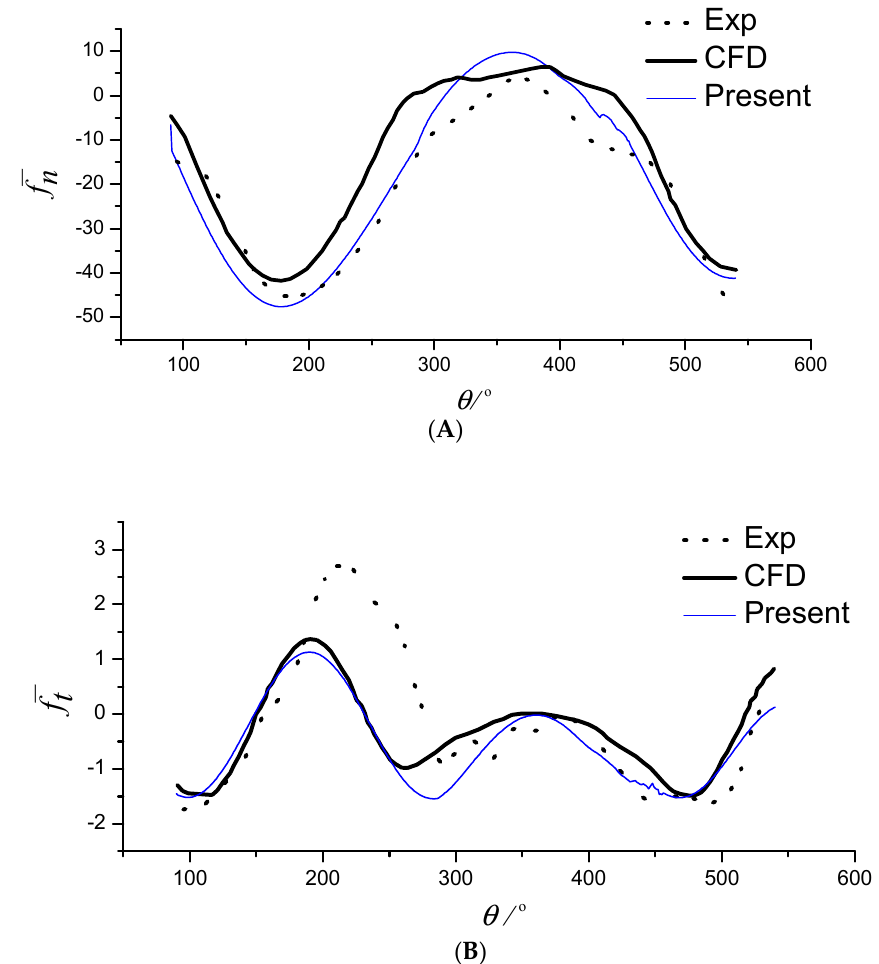
Figure 8. ( A ) Normal force coefficient ( λ = 7.5, Z = 2); ( B ) tangential force coefficient ( λ = 7.5, Z = 2).